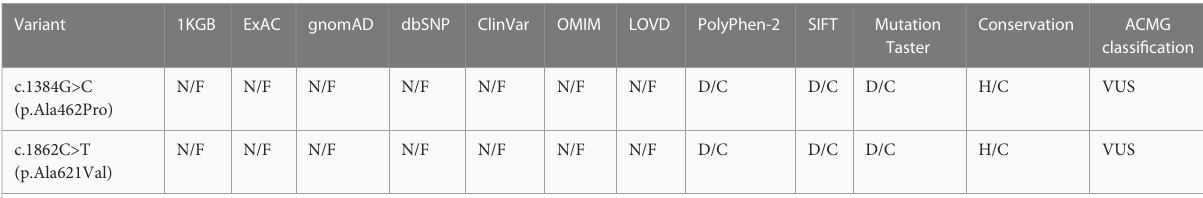
TABLE 2 Bioinformatic prediction of the FSHR